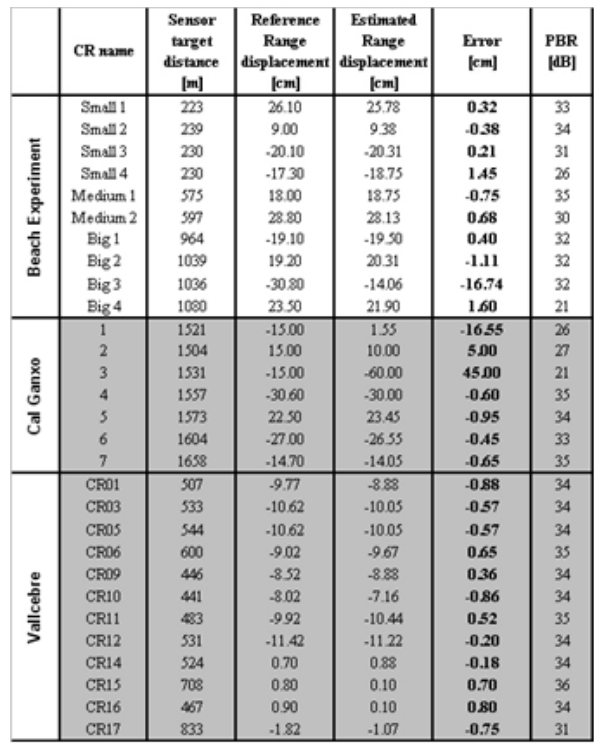
Table 1: results of the GBSAR-amplitude image matching